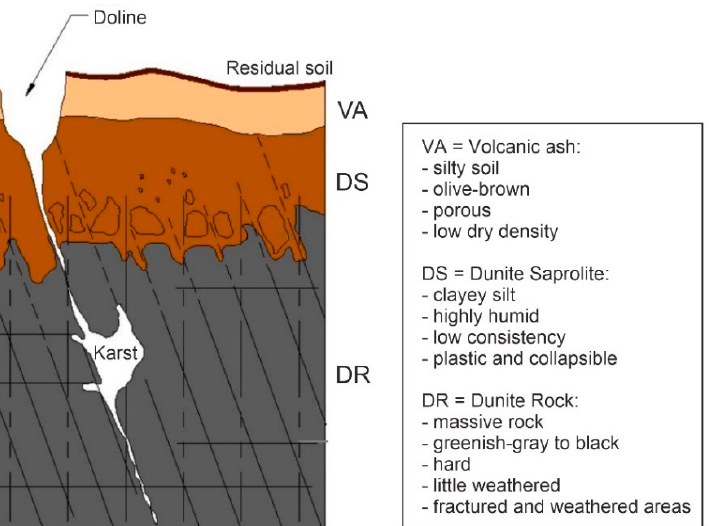
Figure 2. Idealized column profile of the Medellín Dunite with pseudokarst structures; dimensions are not given, because they vary to an evident extent [12] (after Figure 7.6).